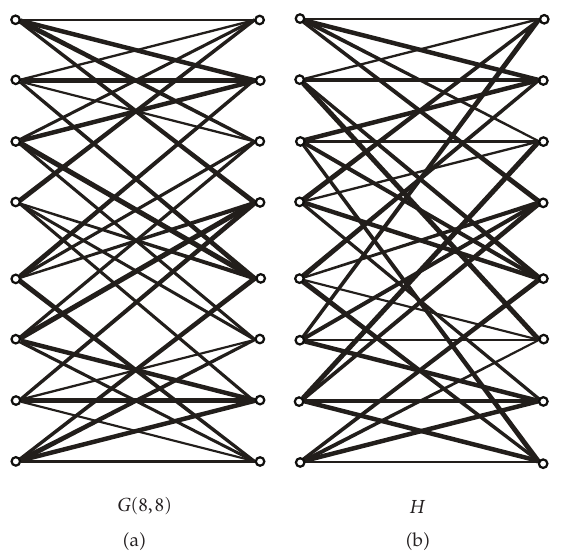
Figure 2: Two nonisomorphic S -graphs with minimum | W | . Any two vertices of H at distance 2 from each other have exactly 2 common